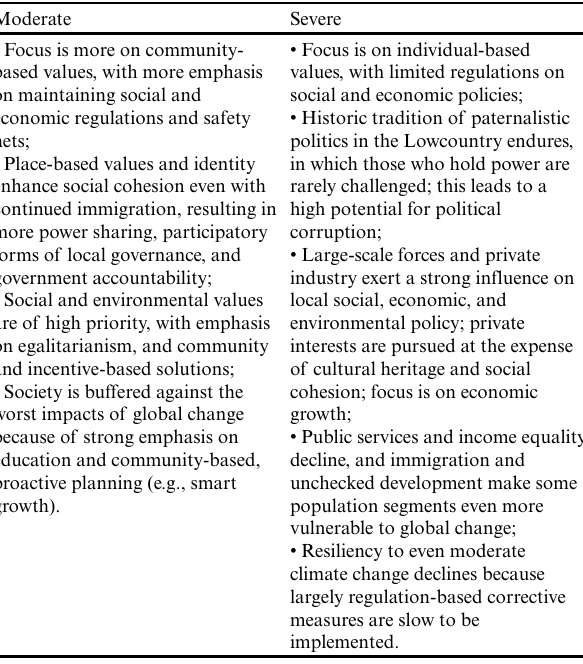
Table 4 . Characterizations of moderate and severe local values and power structures used to develop alternative future scenarios for the Lowcountry of South